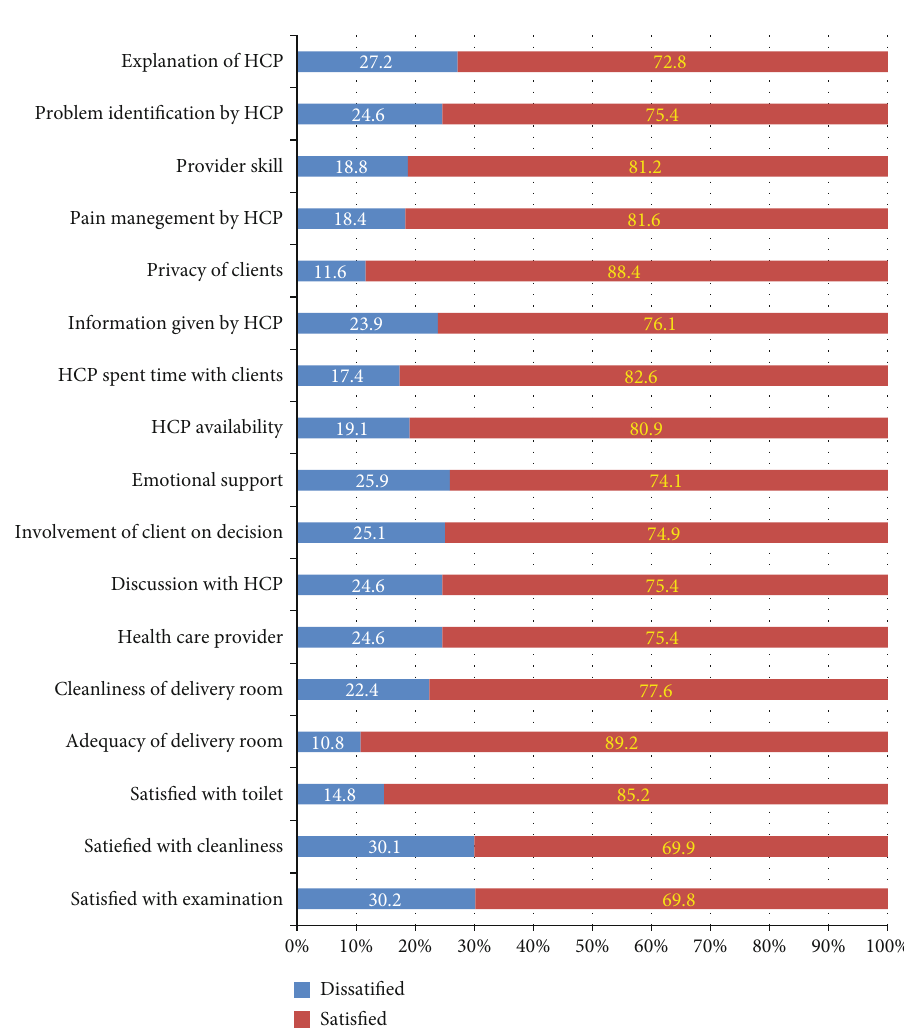
Figure 1: Maternal satisfaction among mothers who gave birth at public hospitals in North Wollo Zone, Northeast Ethiopia, 2019 ( n = 398